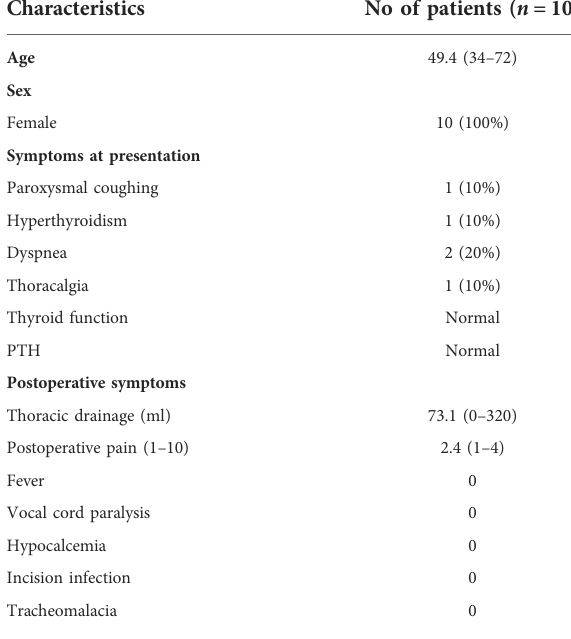
TABLE 1 Patient characteristics and postoperative